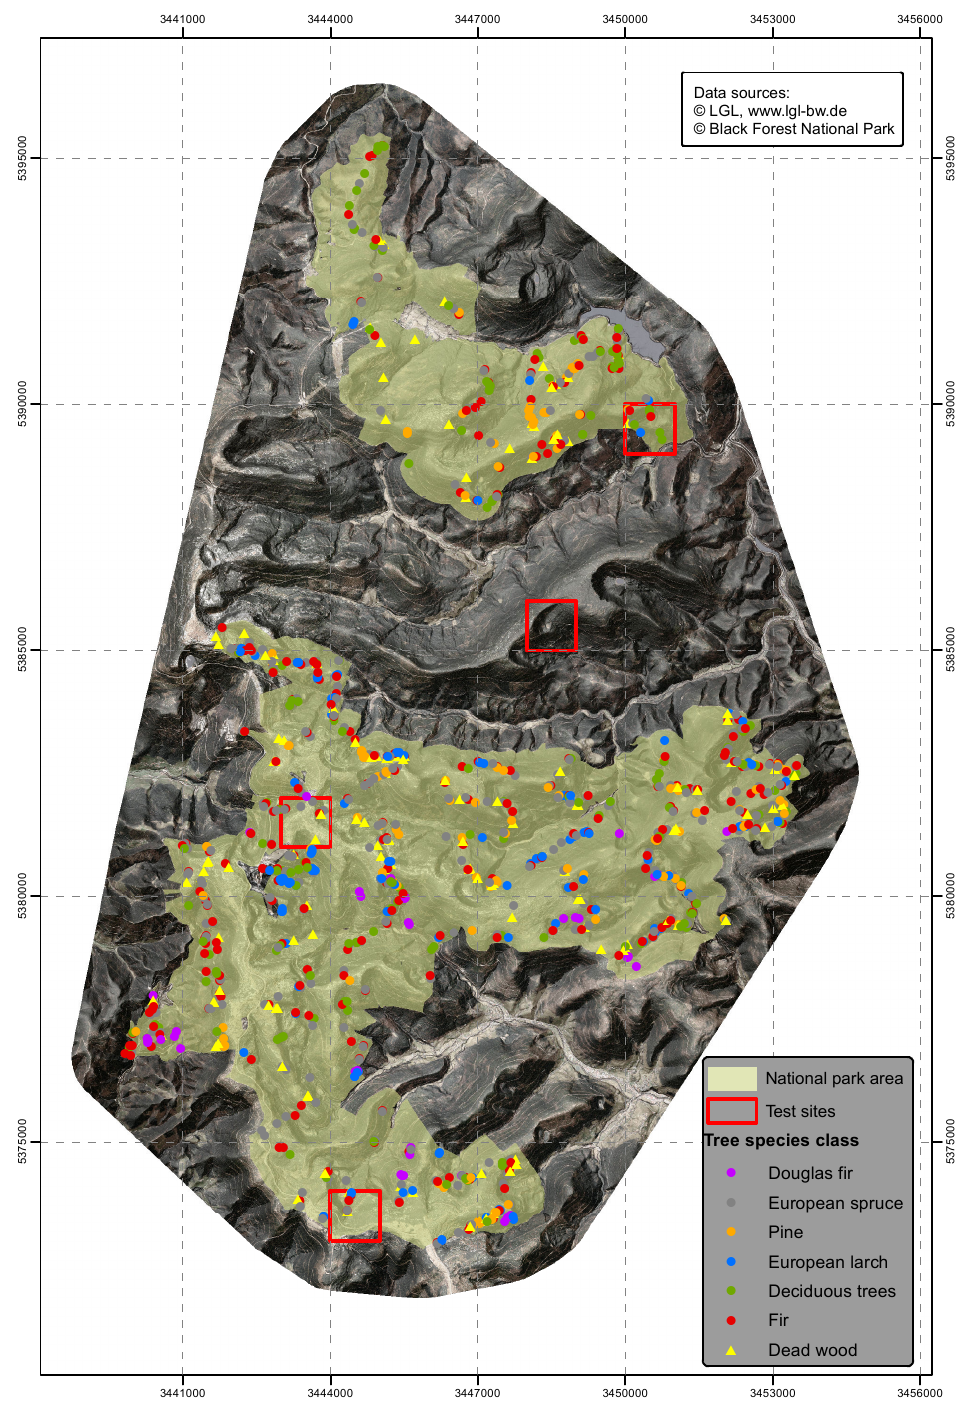
Figure 3. The location of the trees used as training dataset within the study